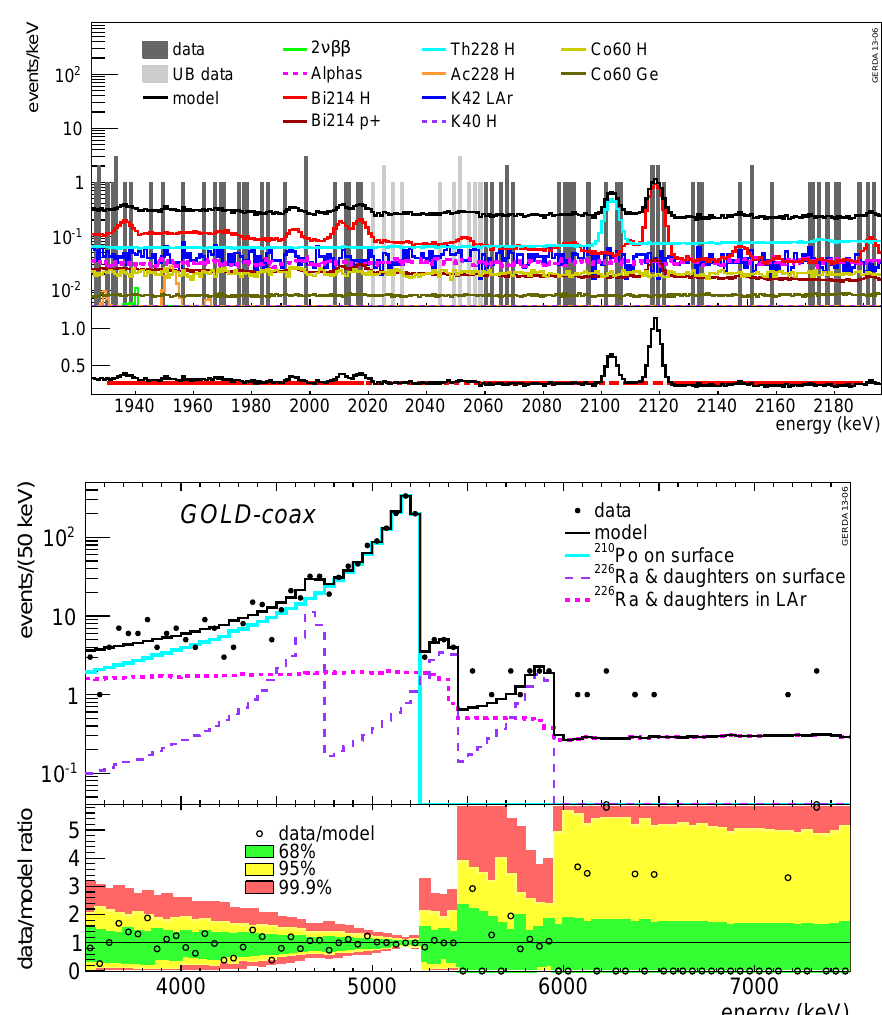
Figure 13. Top: Decomposition of the coax data set energy spectrum. The individual components are identified by characteristic gamma or α lines. Bottom: The energy spectrum of the GOLD COAX and its decomposition in the α region for E > 3 Mev. The 210 Po and 226 Ra α lines are very